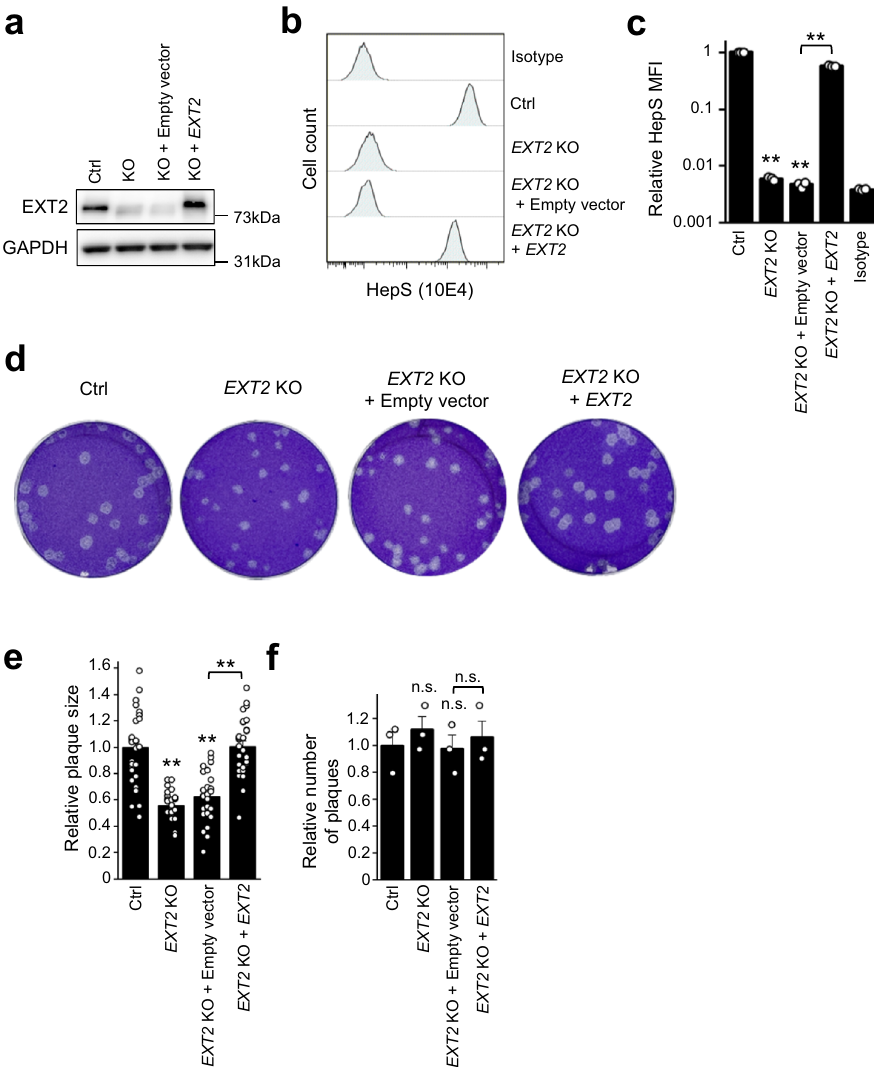
Fig. 3 HepS is important for HSV-1 cell-to-cell infection. a Western blotting con fi rming the absence or complementation of EXT2 expression in the KO and complemented clones of RPE-1 cells. b , c HepS expression analysis by FACS. The graph summarizes the MFI of the HepS expression analysis of three independent experiments ( c ). The results are presented as means ± SEM. e – f HSV-1 cell-to-cell spreading assay. Each clone was inoculated with 30 cells/ well of wildtype RPE-1, which pre-infected with HSV-1 and then incubated in a media containing 5 mg/mL pooled human IgG ( d ). The areas of 10 individual plaques were measured ( e ), and the number of plaques was counted ( f ). The results are presented as means ± SEM of three independent experiments and shown as the relative size ( e ) and the relative number of plaques ( f ). Double asterisks, p < 0.01; n.s. not signi fi